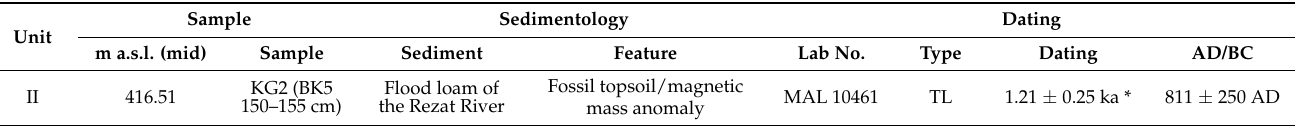
Table 2. Stratigraphic position and dating of the magnetic mass anomaly by thermoluminescence dating. Sample KG-TL2 from the core BK5 (same position as BK3) was intensively heated and provided reliable dating of the magnetic mass anomaly. Unit